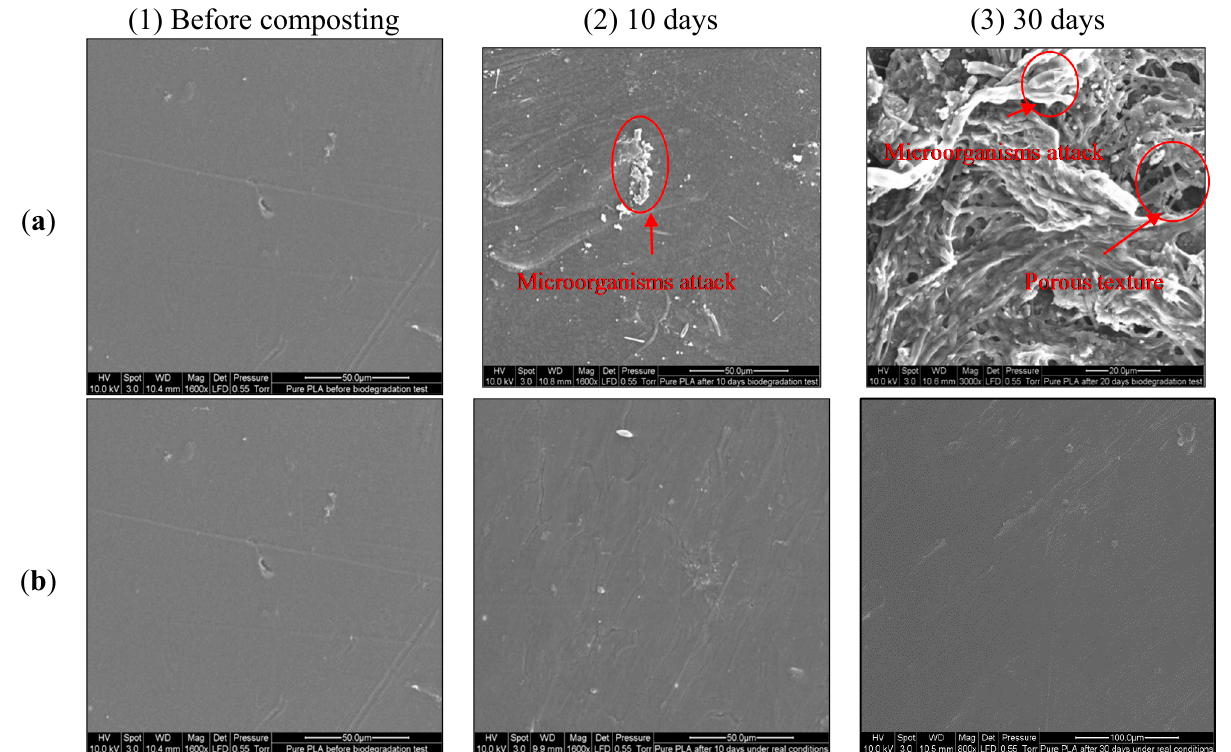
Figure 9. ESEM images of virgin PLA in controlled and real composting conditions. ( a ) Controlled composting conditions; and ( b ) Real composting conditions.